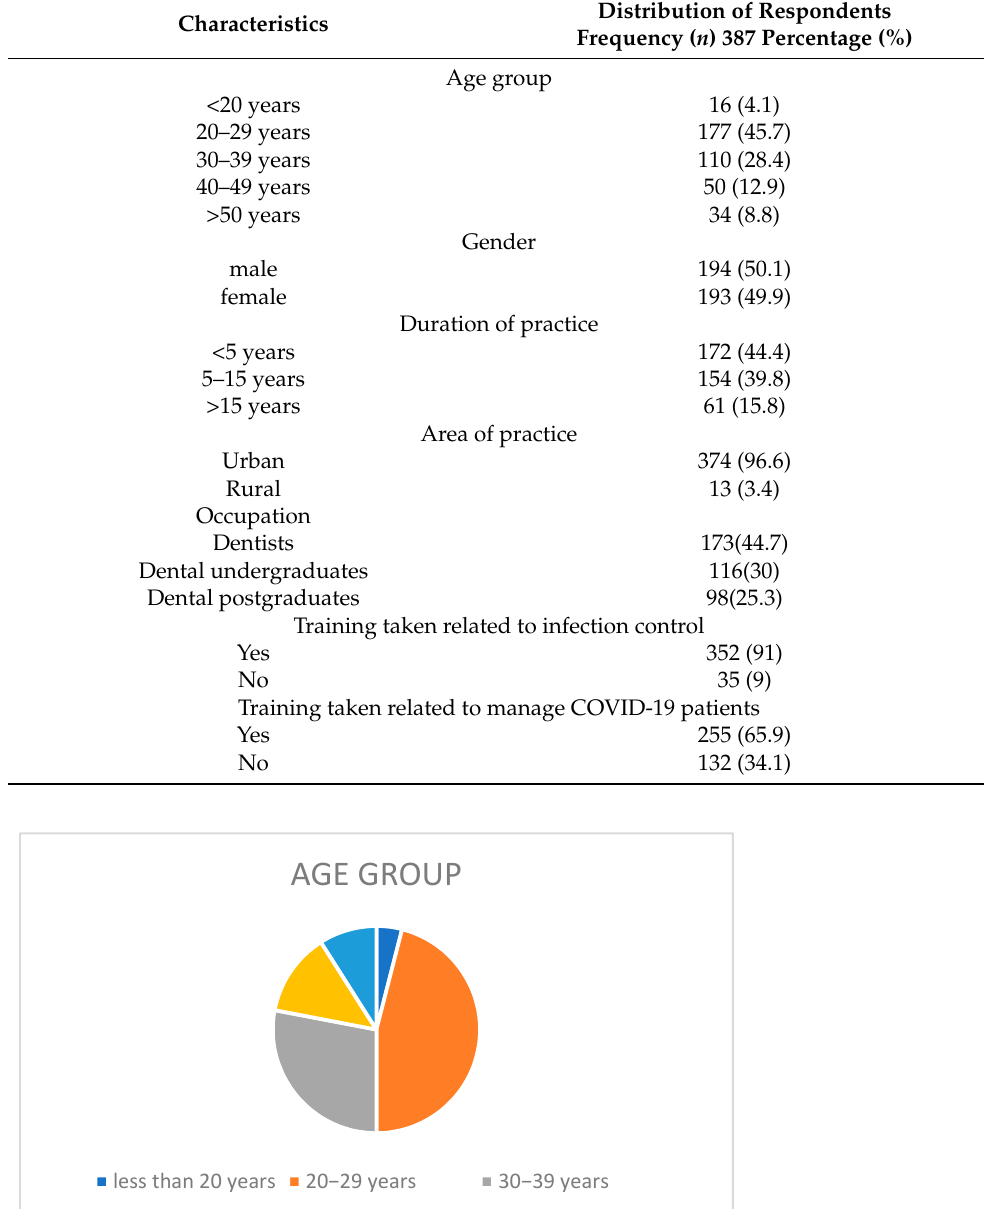
Table 1. Distribution of participants based on demographic characteristics.